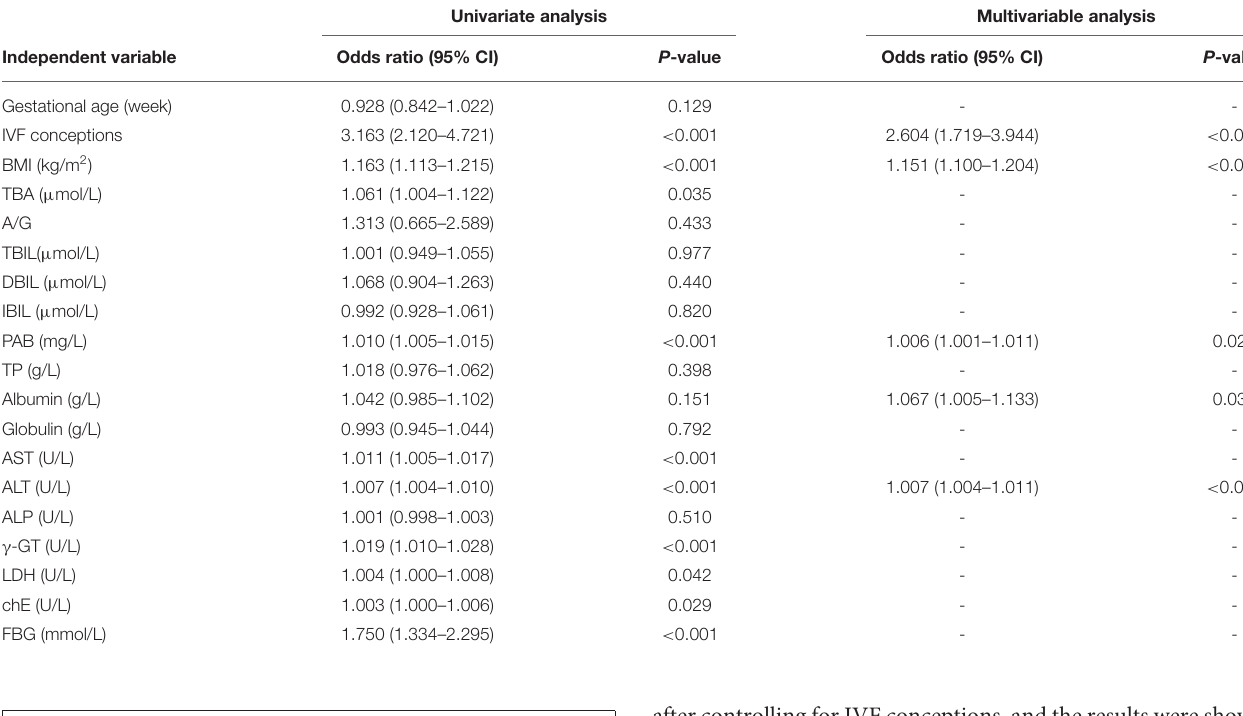
TABLE 2 | Regression analysis of factors from maternal characteristics biochemical parameters for predicting FF in 7,910 pregnancies.